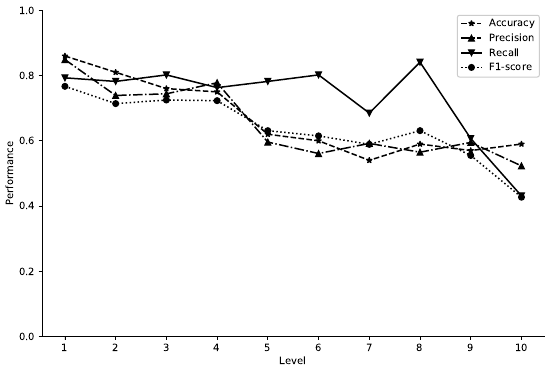
Figure 7. The performance of MM-based BiLSTM.